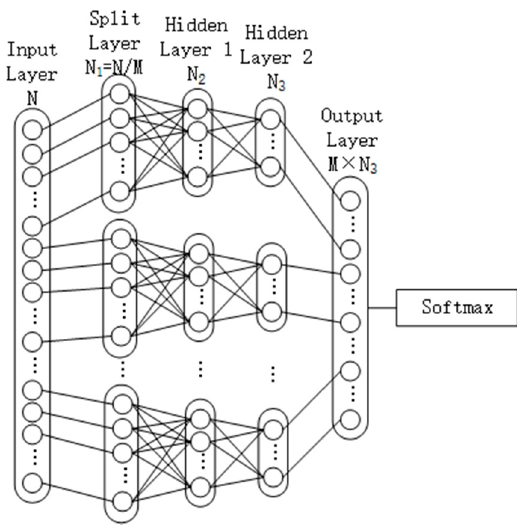
Figure 5. The structure of split-based deep feature transform network.